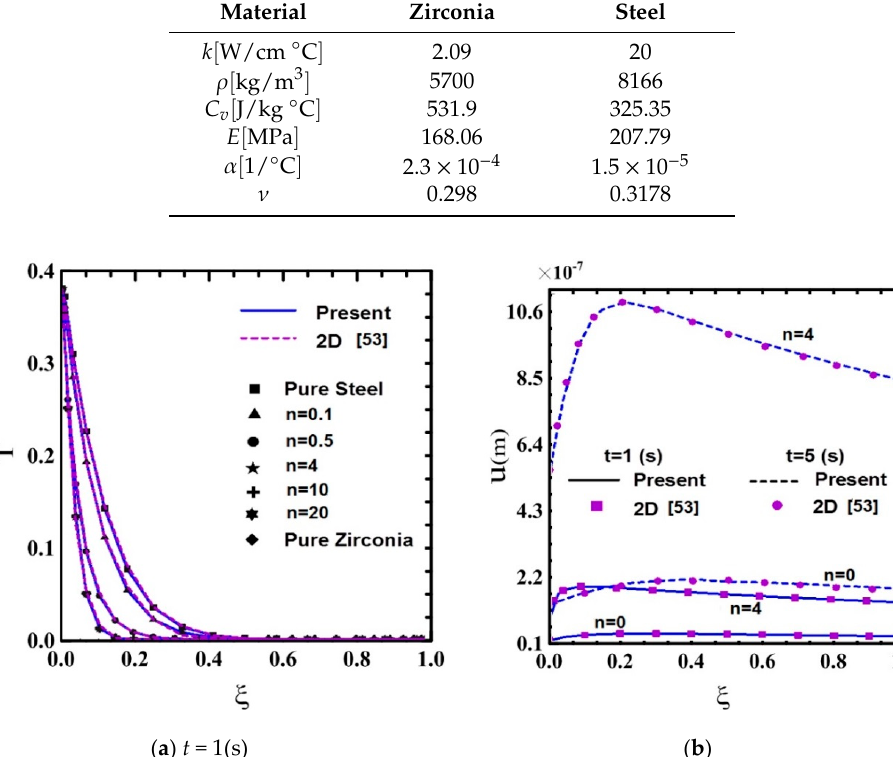
Figure 4. ( a , b ): Transient dimensionless temperature distributions and displacement field across the thickness of an FG hollow cylinder subjected to a prescribed temperature at its inner surface ( (cid:16) (cid:17) R i = 4cm, R o = 6cm, L = 20cm, T = T / T 0 , η = 0.5 Table 4. Material properties of ceramic (Zirconia) and metal (steel) [53].